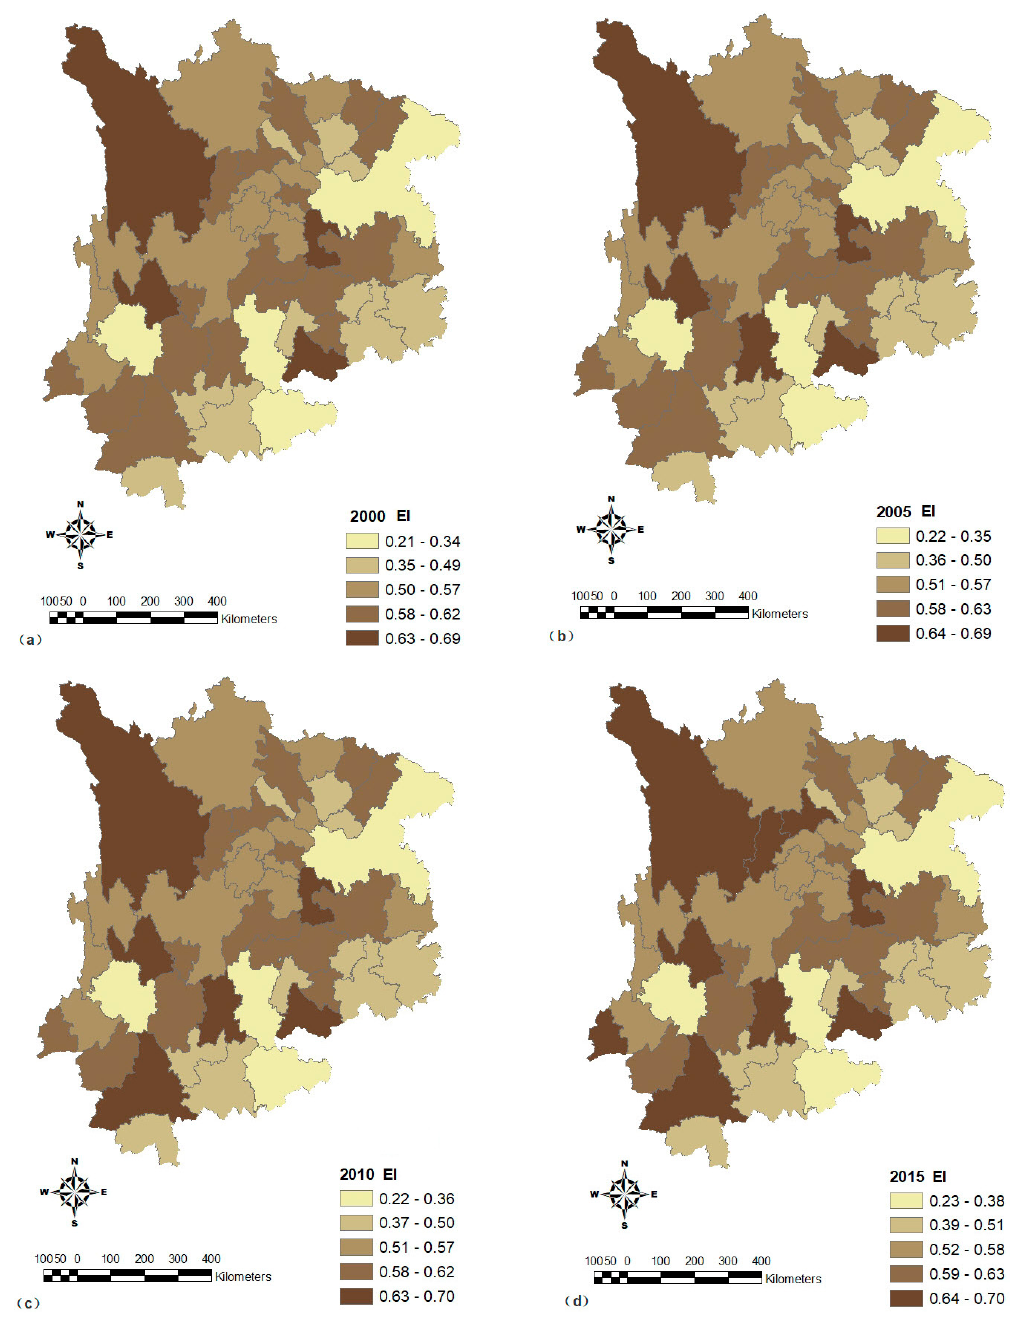
Figure 7. The variation of land use mix quantified by the Entropy Index (EI) in four different years: ( a ) 2000; ( b ) 2005; ( c ) 2010; and ( d ) 2015.